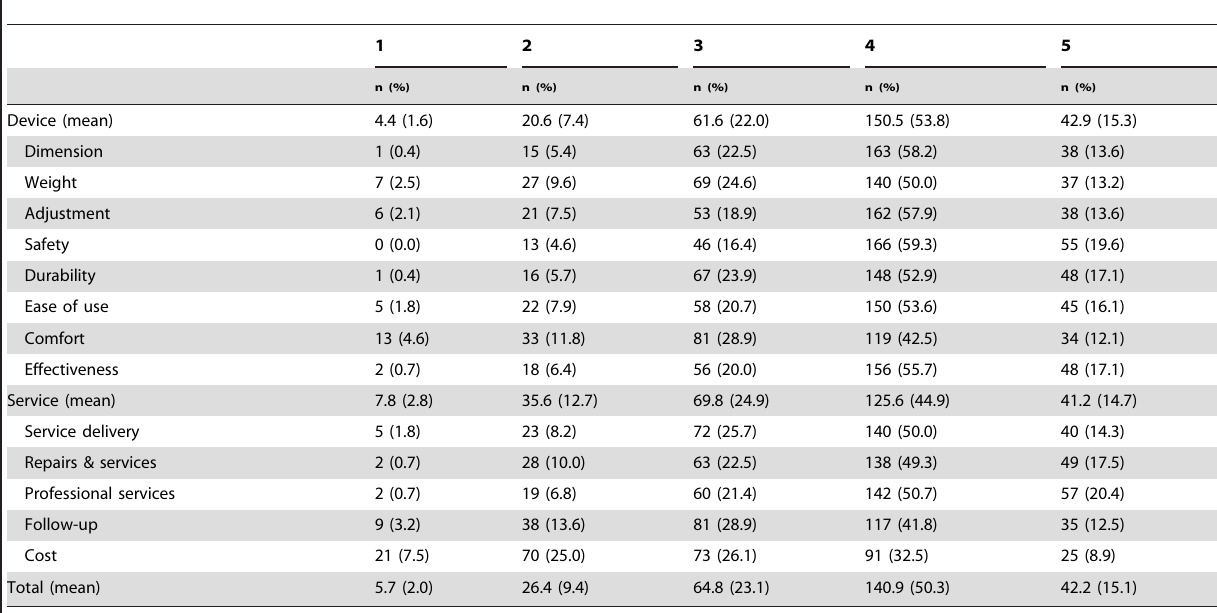
Table 2. Number and percentage of participants who rating the